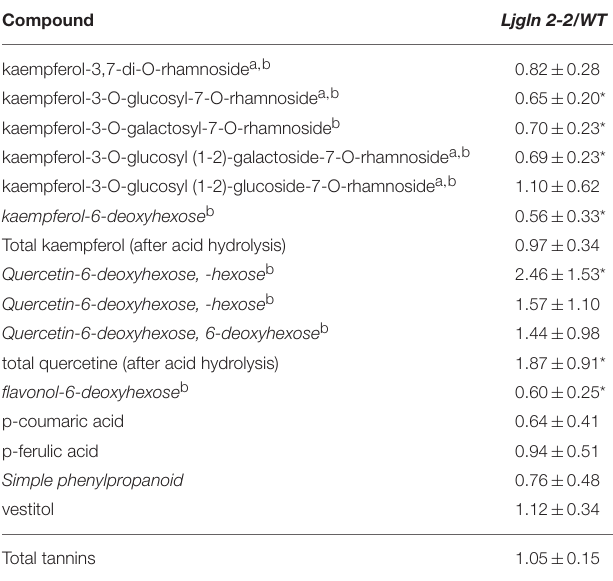
TABLE 4 | Relative levels of phenolic compounds in WT and Ljgln2-2 leaves under control conditions (normal watering and suppressed PR).